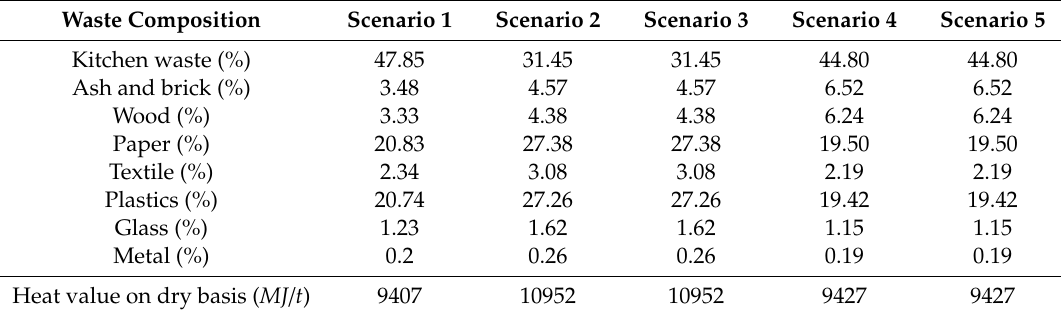
Table 4. Waste component and heat value of residual mixed waste in five